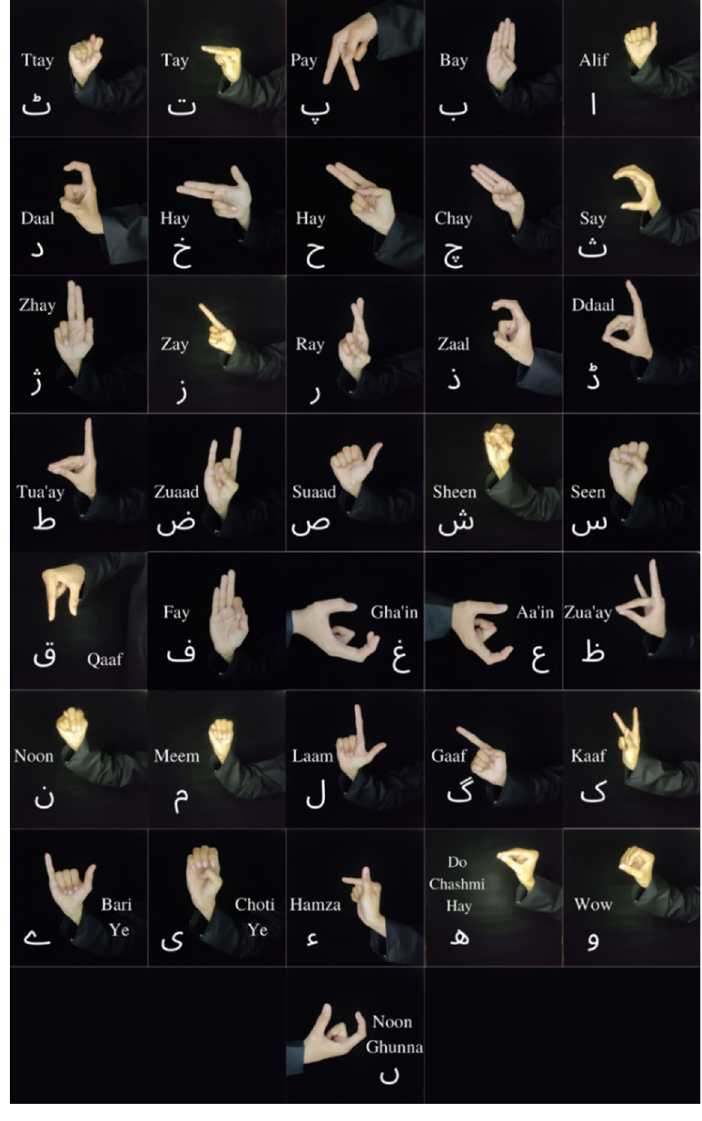
Figure 1. PSL static alphabets.